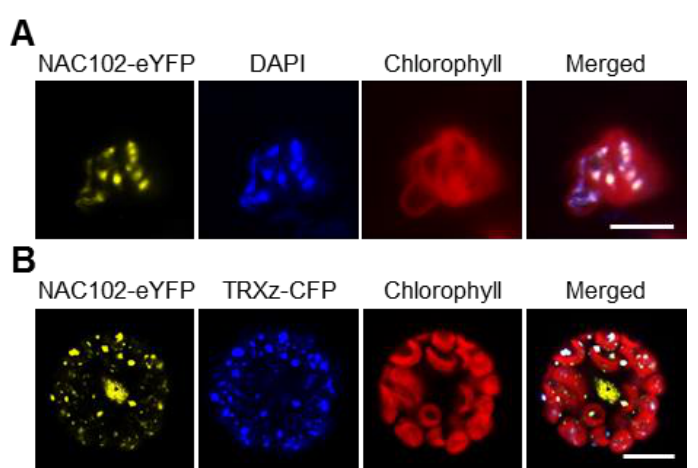
Figure 4. NAC102 associates with chloroplast nucleoids. ( A ) Colocalization of NAC102-eYFP and chloroplast nucleoids. The chloroplasts were isolated from NAC102-eYFP transgenic lines and stained with DAPI. The pictures were captured using confocal microscopy. Bar = 5 µm. ( B ) Co-localization of NAC102-eYFP and chloroplast nucleoid marker TRXz–CFP. The NAC102-eYFP and TRXz-CFP were transiently co-expressed in Arabidopsis protoplasts. The pictures were captured using confocal microscopy. Bar = 10 µm.